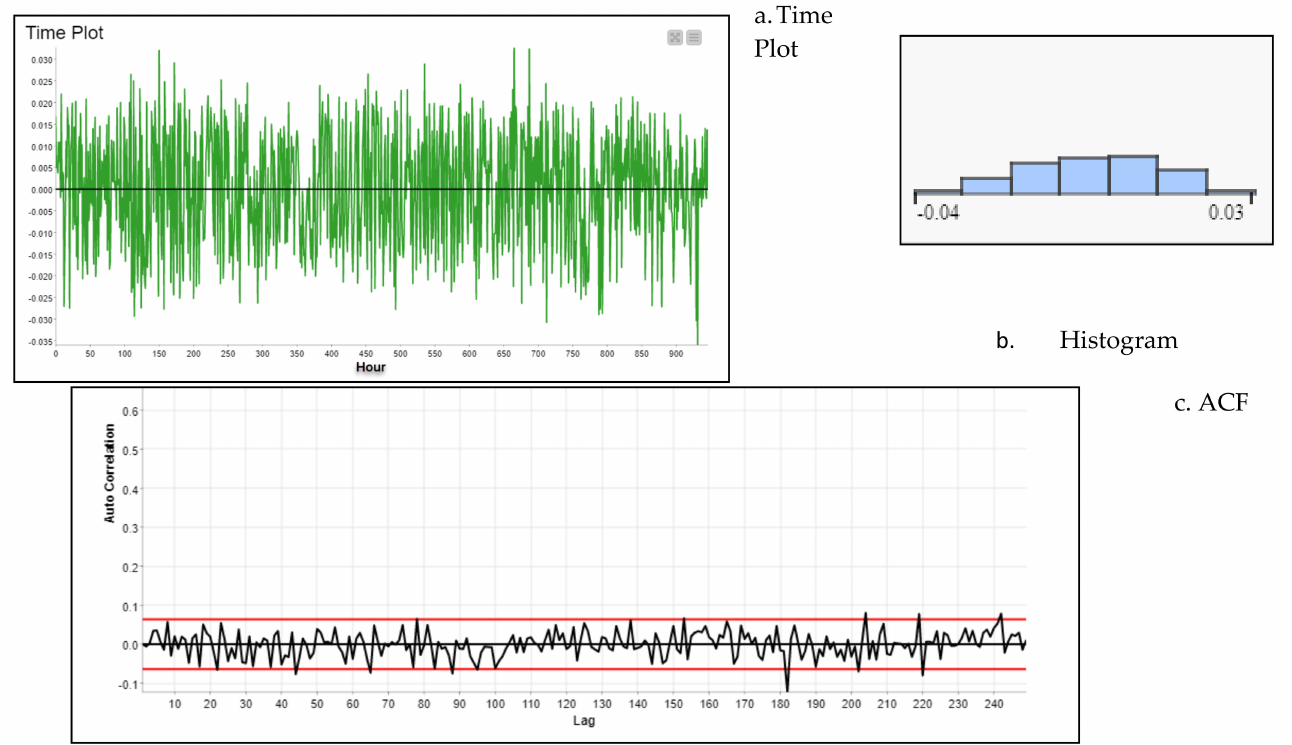
Figure 18. Analysis of The Residuals of Cluster